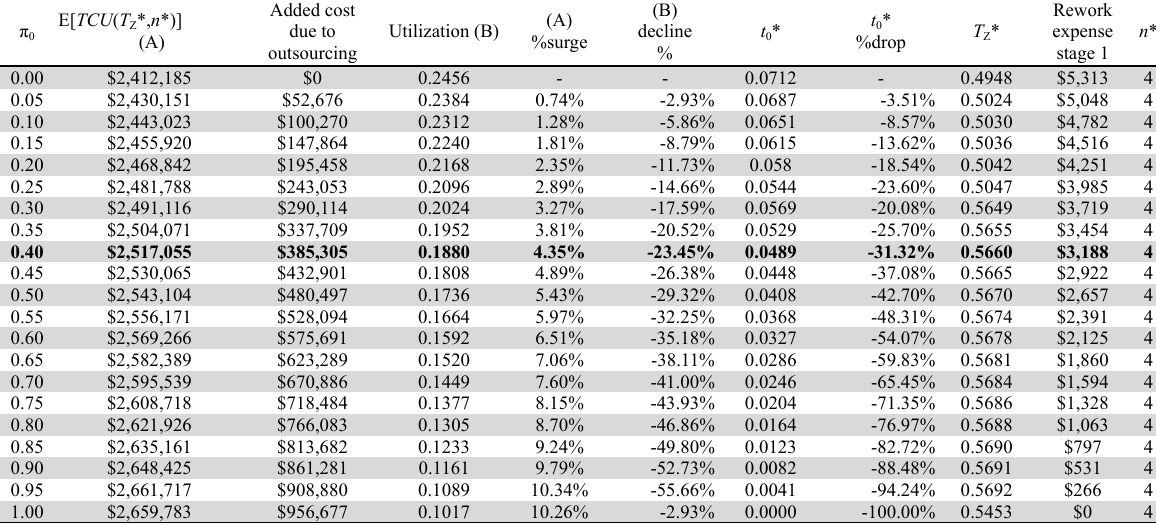
Different critical system-features influenced by outsourcing factor π